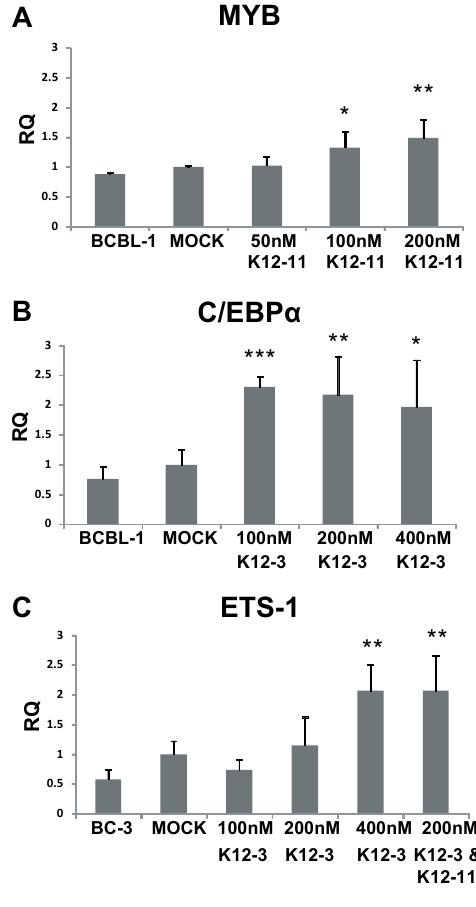
Figure 4. MYB, C/EBPα and Ets-1 expression after miR-K12-11 and miR-K12-3 knockdown in PEL cells. BCBL-1 and BC-3 cells were transfected with the indicated amounts of miRNA-specific antagomir. Total RNA was collected at 48 h, reverse transcribed, and MYB ( A ); C/EBPα ( B ); and Ets-1 ( C ) transcript levels determined by qPCR. All samples were normalized to β-actin expression and compared to gene expression in the mock transfected control. p < 0.05 ( * ), p < 0.01 ( ** ), p < 0.001 ( ***